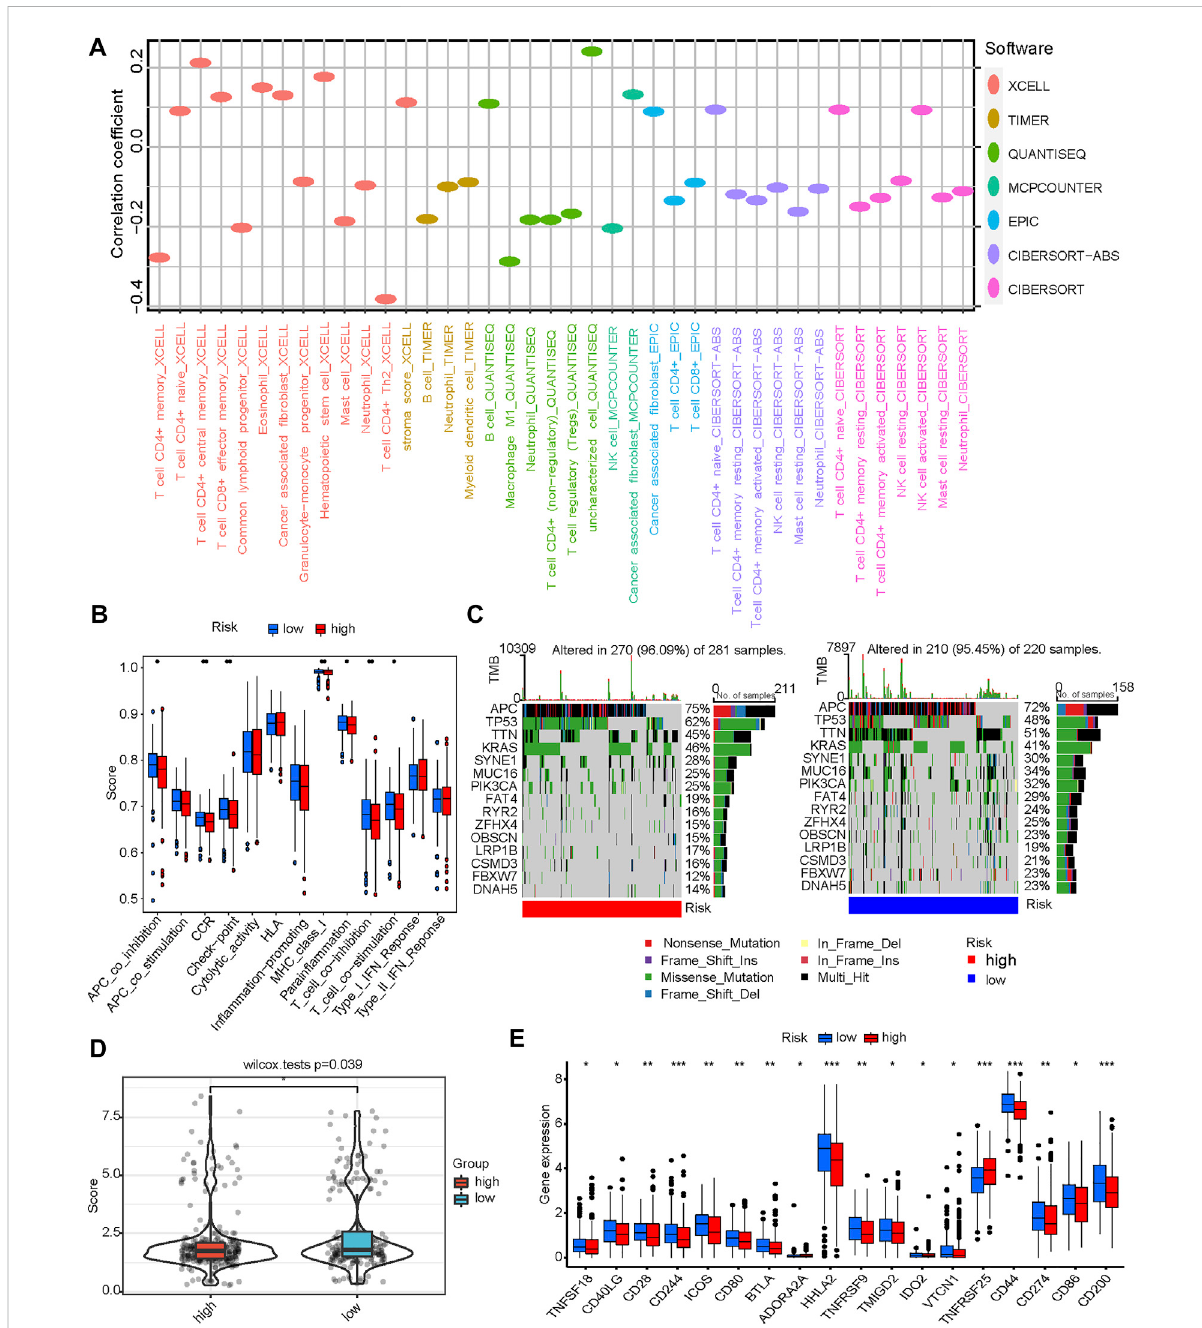
FIGURE 5 Correlation between CRG-Score groups and immunity. (A) Correlation between CRG-Score groups and immune in fi ltration status. (B) Correlation between CRG-Score groups and immune-related pathway activity. (C) Oncoplot represents the top 15 mutated genes between CRG- Scoregroups. (D) Tumormutationalburden(TMB)betweenCRG-Scoregroups. (E) CorrelationbetweenCRG-Scoregroupsandexpressionlevelsof immune checkpoint-related genes. * p < 0.05, ** p < 0.01, *** p <